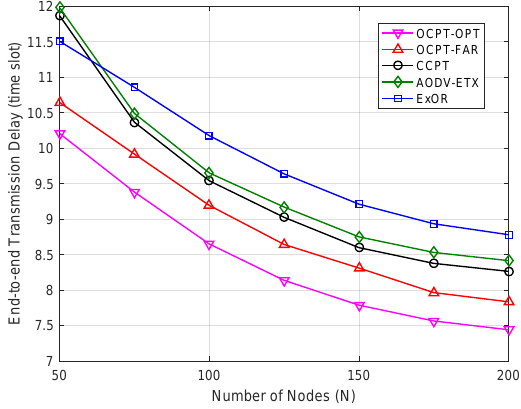
Figure 2. End-to-end transmission delay vs. number of nodes with different schemes under the fixed V s and V d